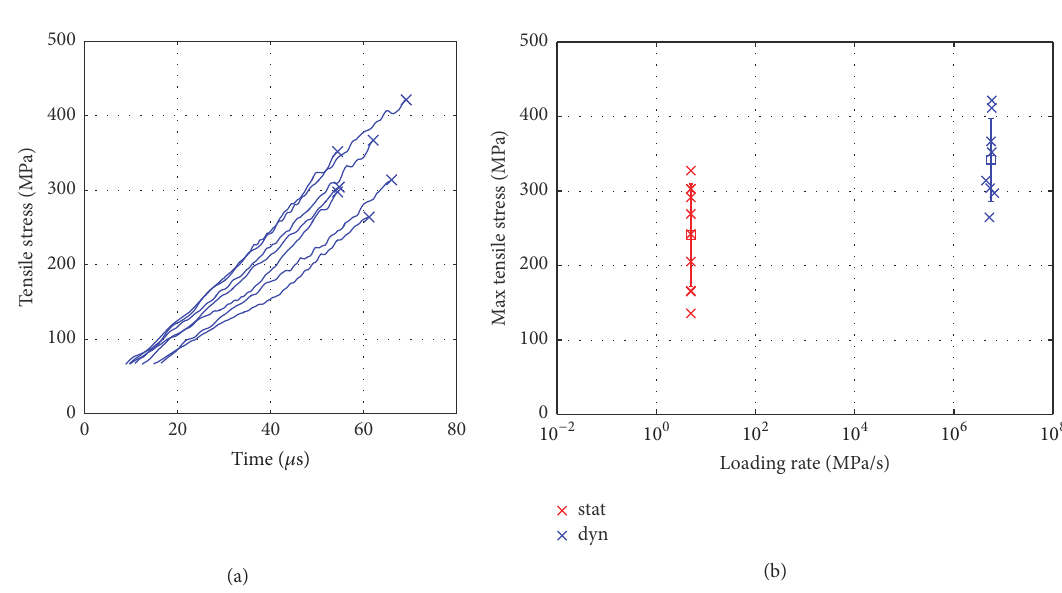
Figure 5: Experimental results in terms of force versus time curves for high loading rate tests (a) and maximum tensile stress at failure versus loading rate